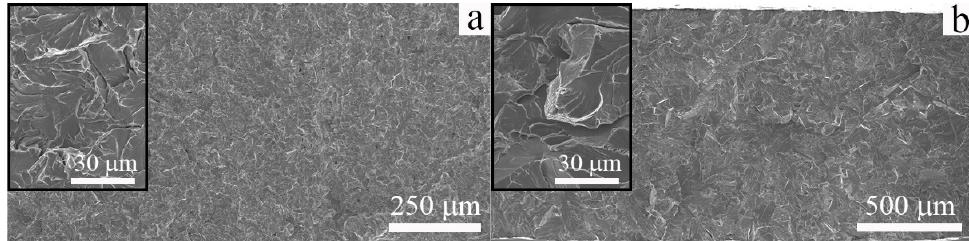
Figure 9. SEM images of fracture surfaces of the low-carbon steel: ( a ) cast and ( b ) EBAM. Specimens were tensile tested to failure at 77 K.